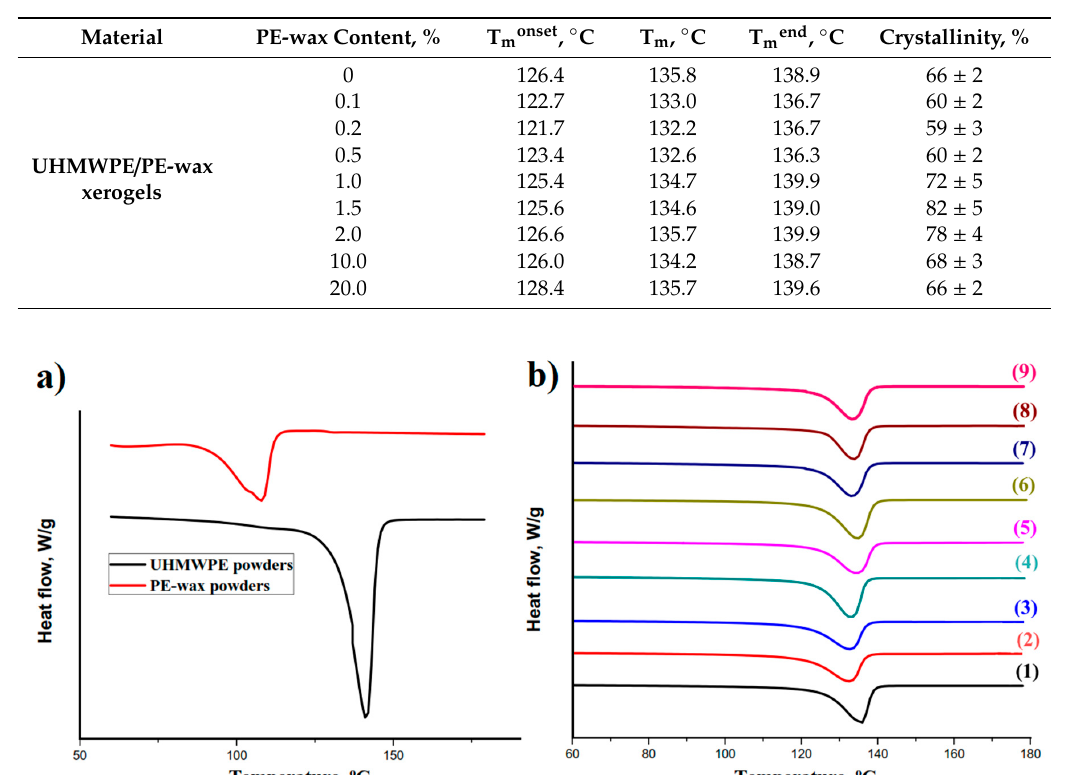
Table 3. DSC test results for the UHMWPE/PE-wax xerogels depending on PE-wax content (± the standard deviation).